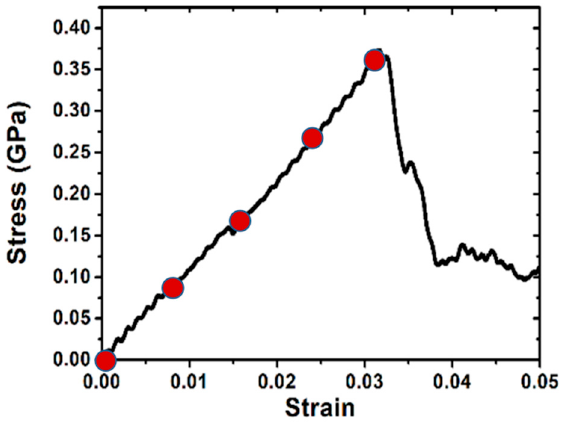
Figure 16. Stress-strain curves in reloading process.